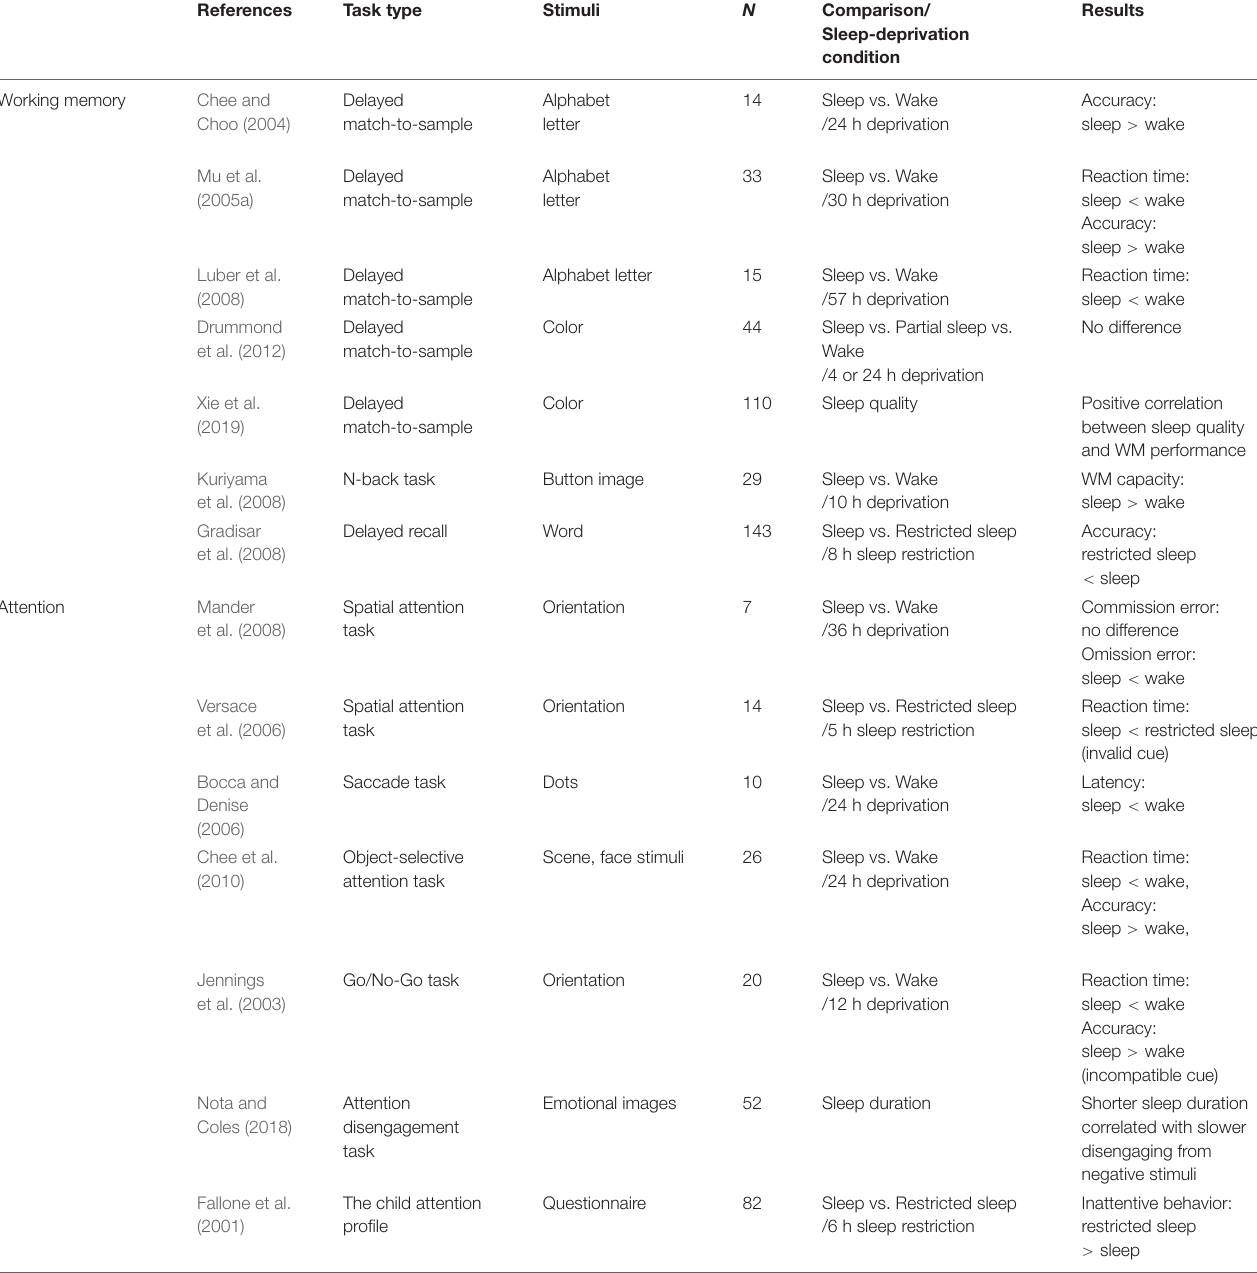
TABLE 3 | Studies of the effects of sleep deprivation on cognitive control